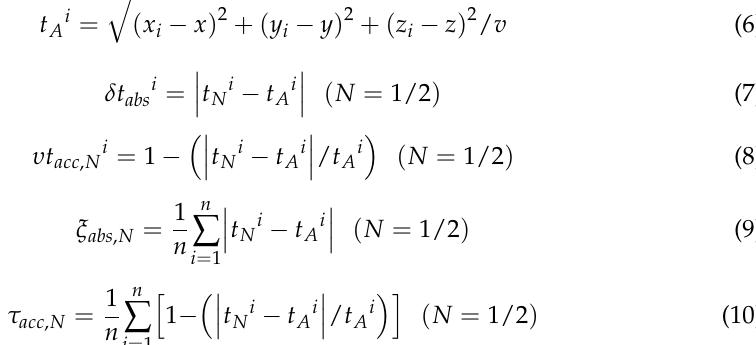
at the node i ; δ t absi denotes the absolute error at the node i ; υ t acci represents the accuracy at the node i ; ξ abs indicates the mean absolute error (MAE) of multiple nodes; τ acc refers to the accuracy of multiple nodes. The subscripts ( N = 1/2 ) correspond to